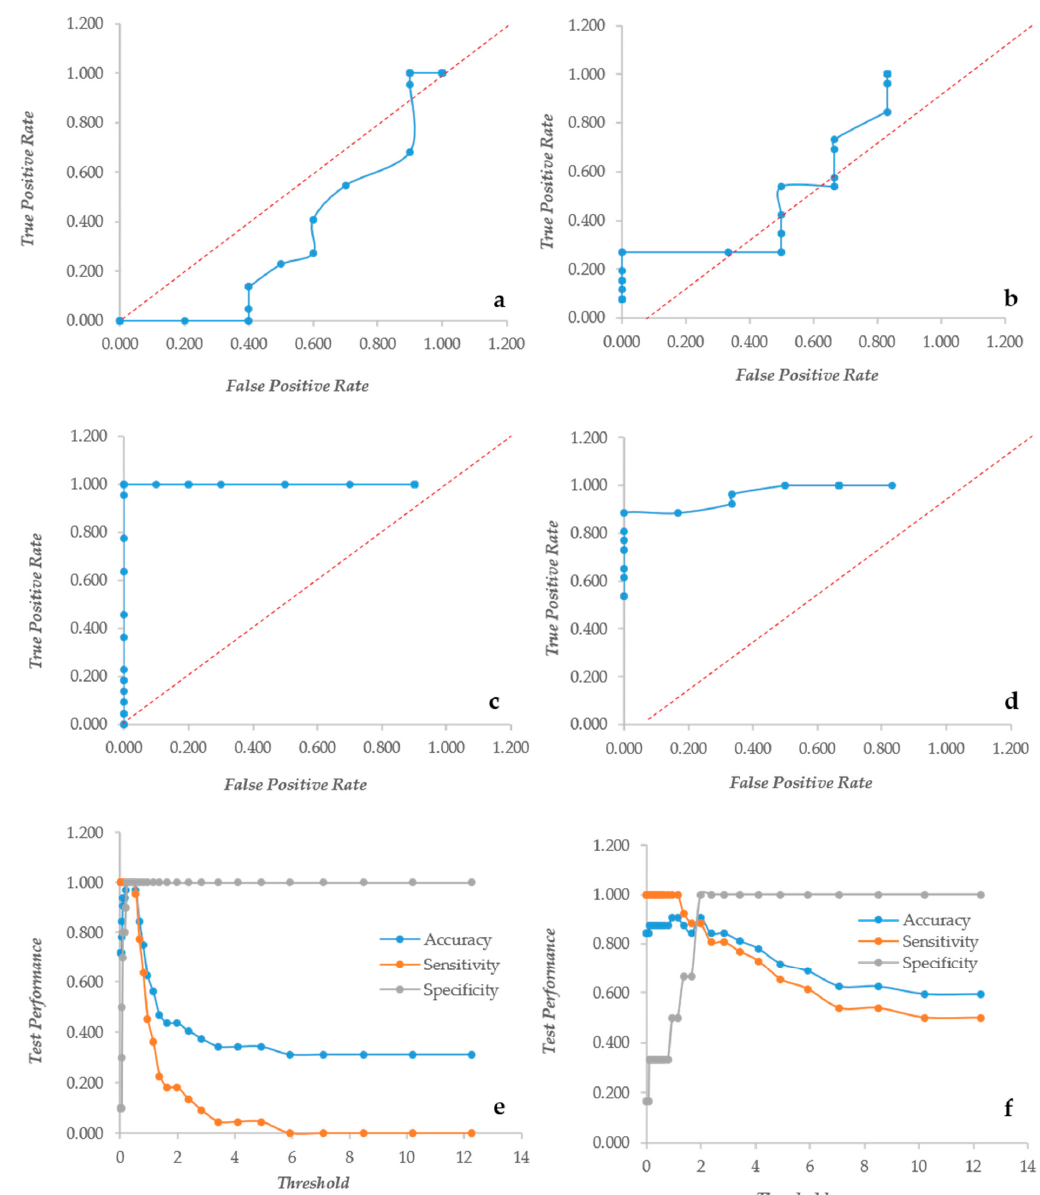
Figure 3. The Response Operator Characteristic (ROC) curves showing the ability to classify normalized XTT to CV rates (XCR, panel ( a ) and ( b )) and Biofilm Specific Activity (BSA, panel ( c – f ). Panels ( a ) and ( b ): the ROC curves for the XCR values of Candida and Staphylococcus respectively; panels ( c ) and ( e ): the ROC curve and its parameters for the BSA values of Candida biofilm; and panels ( d ) and ( f ): the ROC curve and its descriptors for the BSA values of Staphylococcus biofilm.